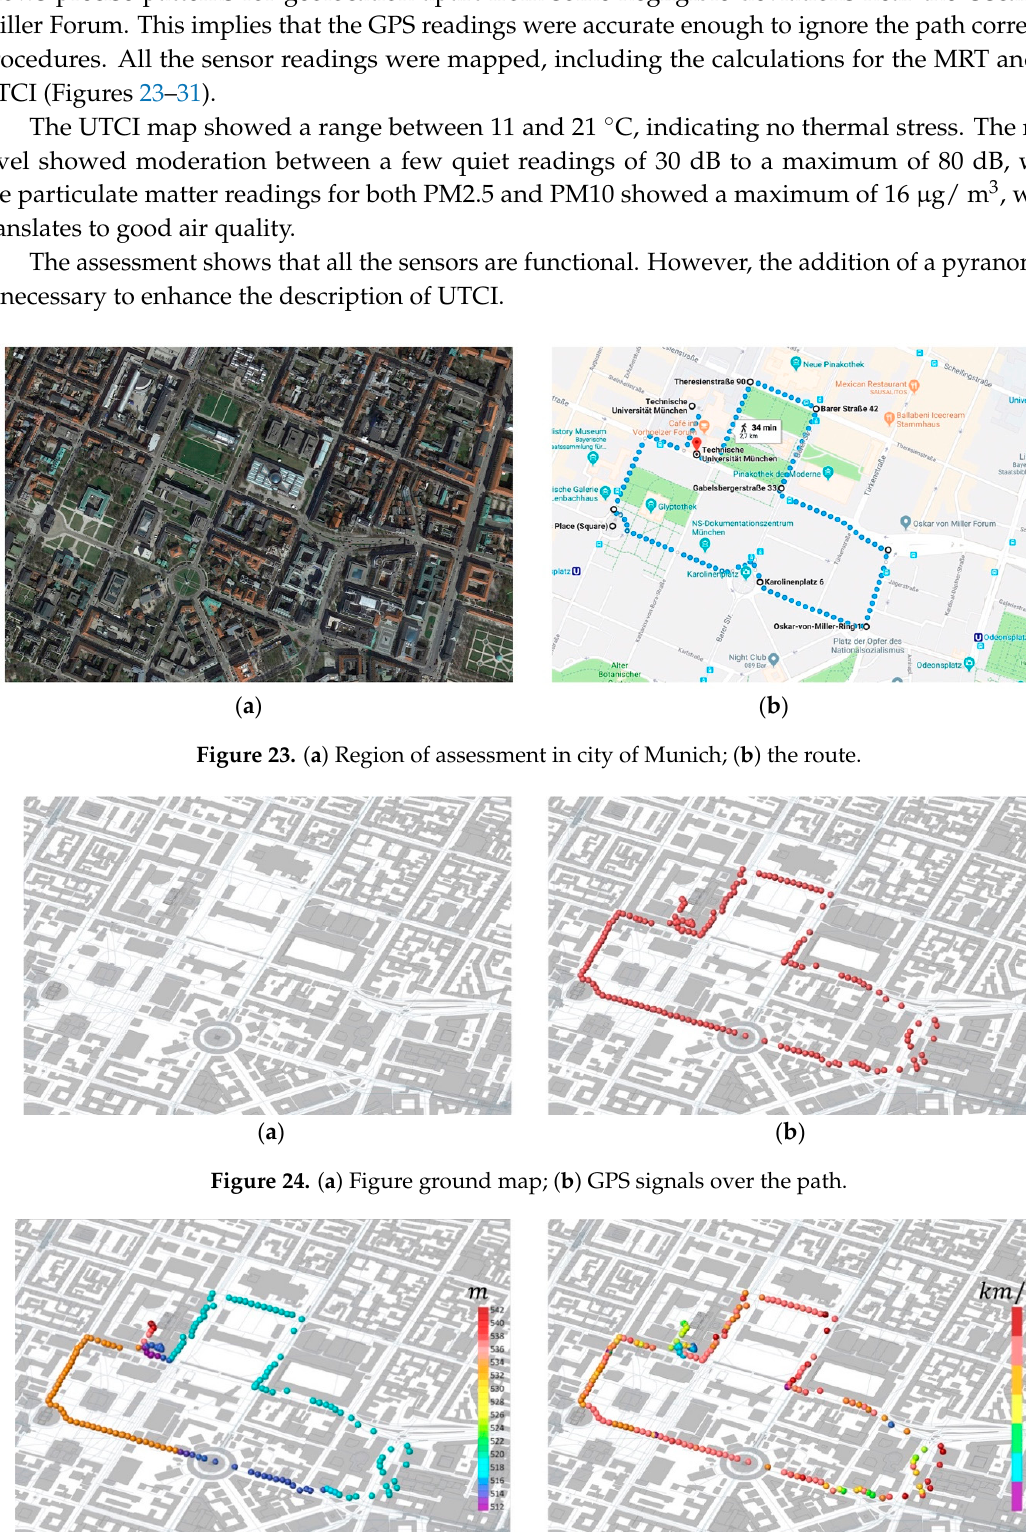
( a ) ( b ) Figure 26. Transient temperature maps: ( a ) globe temperature (°C); ( b ) air temperature (°C).